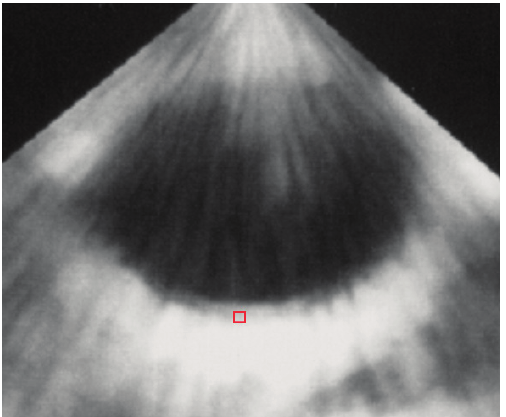
Figure 1. Acquisition of IB value of carotid artery using transthoracic echocardiography. Red square: region-of-interest (11 × 11